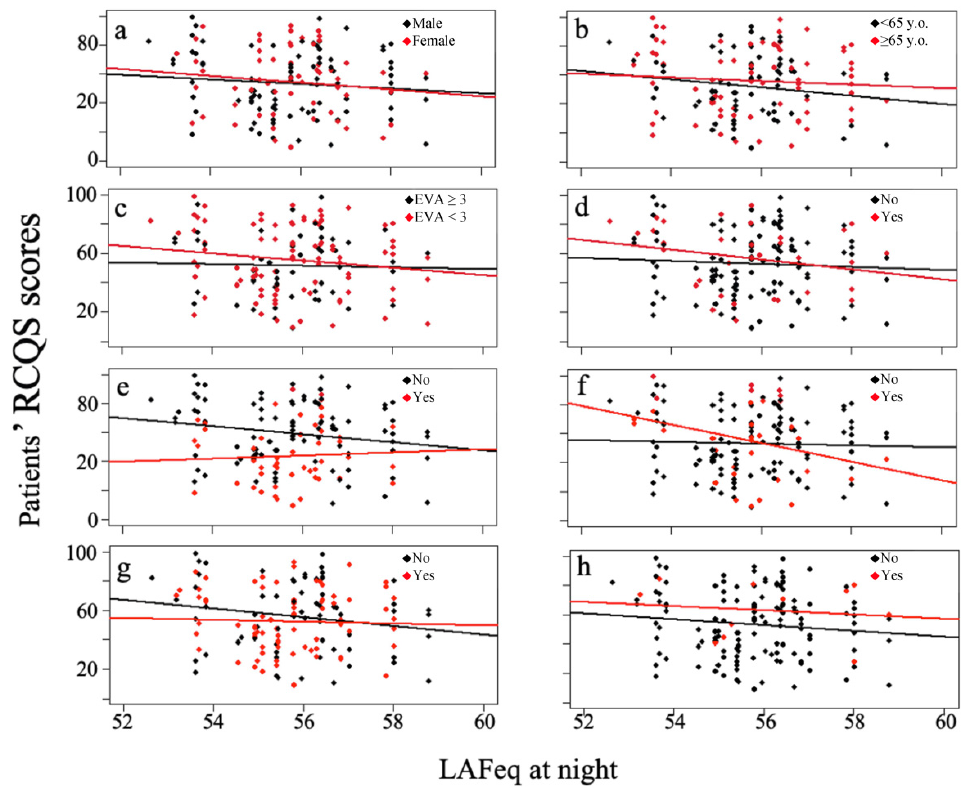
Figure 1. Correlation between patient RCSQ scores and LAFeq at nighttime depending on the covariables; ( a ) gender, ( b ) age, ( c ) VAS ≥ 3 during 2 or more hours, ( d ) urgent surgery, ( e ) hypnotic drug administration, ( f ) nasogastric tube, ( g ) water intake and ( h ) family visit. Regarding the nurses’ and patients’ perception of the patients’ sleep, a correlation was found between the two RCSQ evaluations (r = 0.43 (0.29–0.55), p < 0.001) (Figure 2b). Despite this agreement, nurses tended to overestimate their patients’ sleep by more than 8 points on the RCSQ score (Figure 2c). Nurse’s RCSQ scores were used to compare them with patient’s RCSQ scores and not as an independent measurement; thus, only a com- parative analysis was performed between both results.